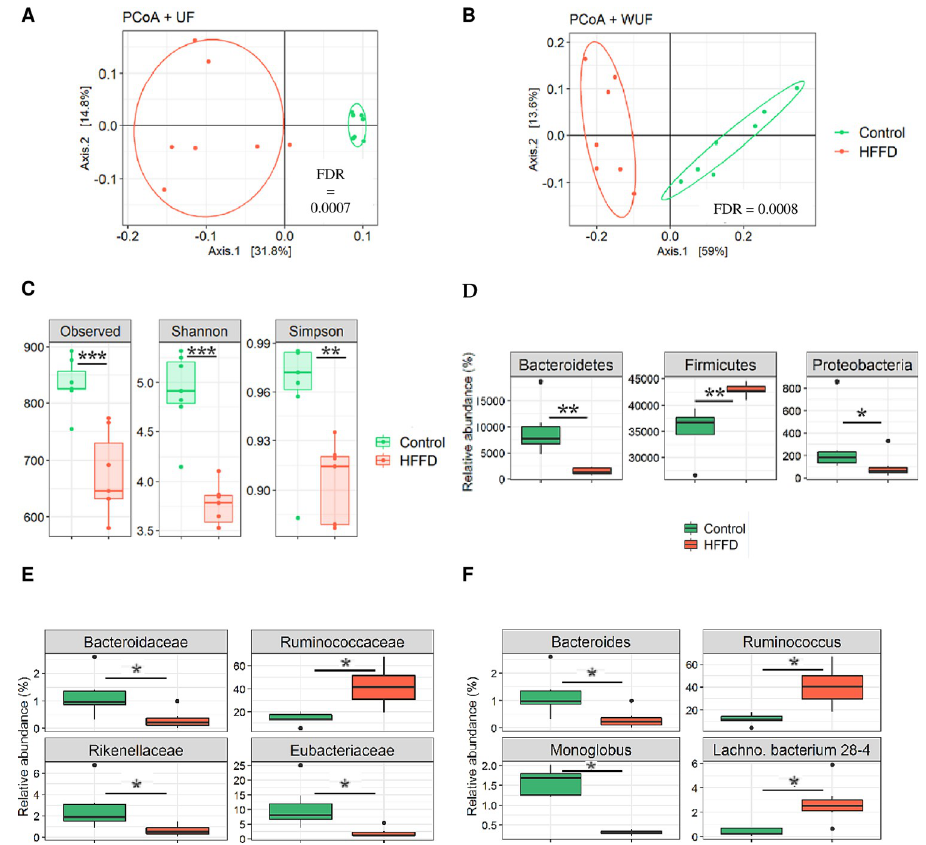
Fig 6. Gut bacterial community analysis by 16S rRNA gene high-throughput sequencing. Principle coordinate analysis (PCoA) based on A) Unifrac (UF) and B) weighted Unifrac (WUF) distance matrices, reveals useful information about the phylogenetic relationship and composition of bacterial microbiota in the different animal groups. C) Alpha diversity, which takes into account the community richness, evenness and diversity, was measured by three different indexes: Observed number of OTUs, Shannon and Simpson. Differences in relative abundance of bacterial taxa at the D) Phylum, E) Family and F) Genus levels. Data are represented as box plots. � FDR < 0.05, �� FDR < 0.01 and ��� FDR < 0.001 (n = 7 for Control and n = 7 for